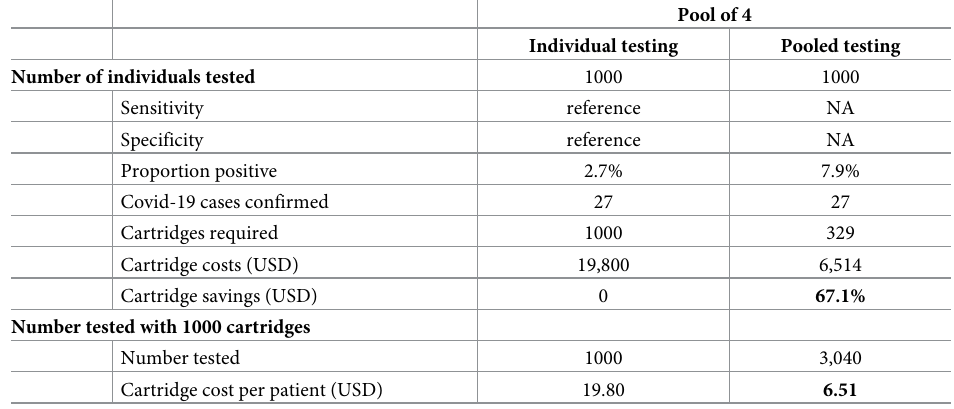
Table 3. Cost and diagnostic savings to screen 1000 consecutive patients using the pooling method and number of patients that could be tested with 1000 Xpert Xpress SARS-CoV-2